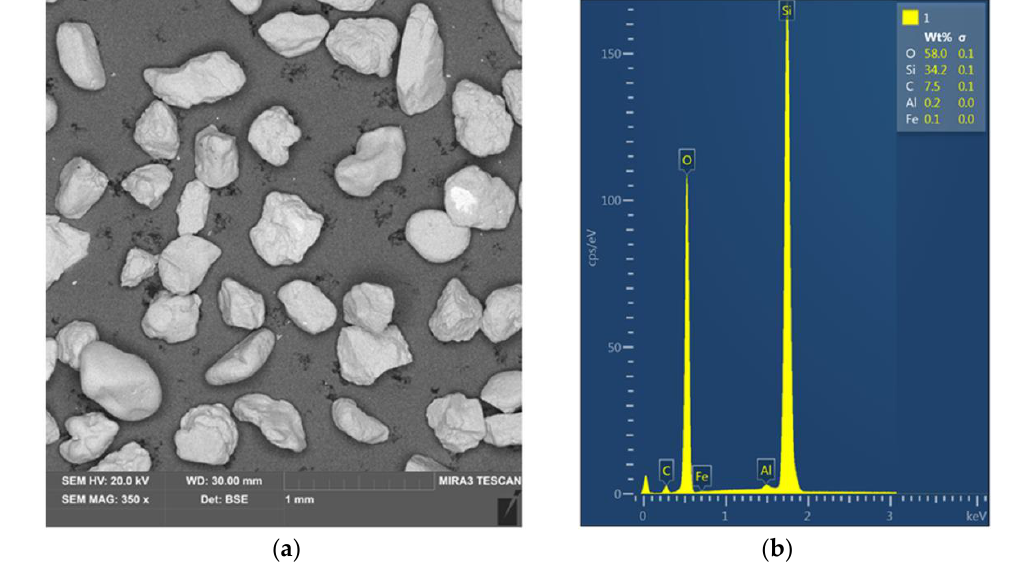
Figure 1. ( a ) SEM micrograph and ( b ) SEM-EDS analysis of the high-silica sand. X-ray diffraction (XRD) analysis was performed on a diffractometer Empyrean